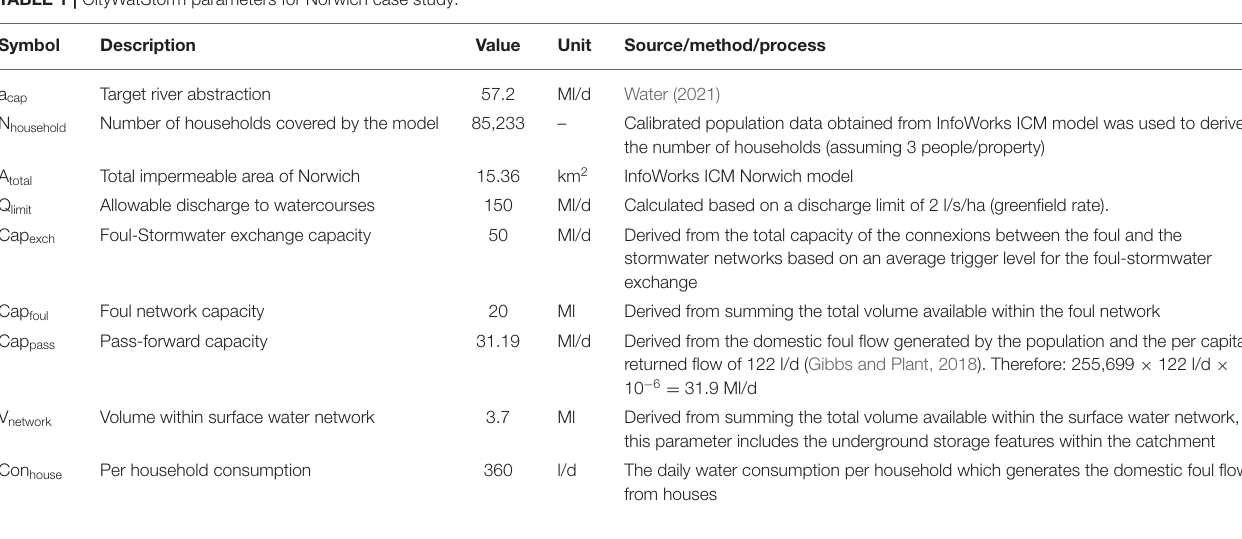
TABLE 1 | CityWatStorm parameters for Norwich case